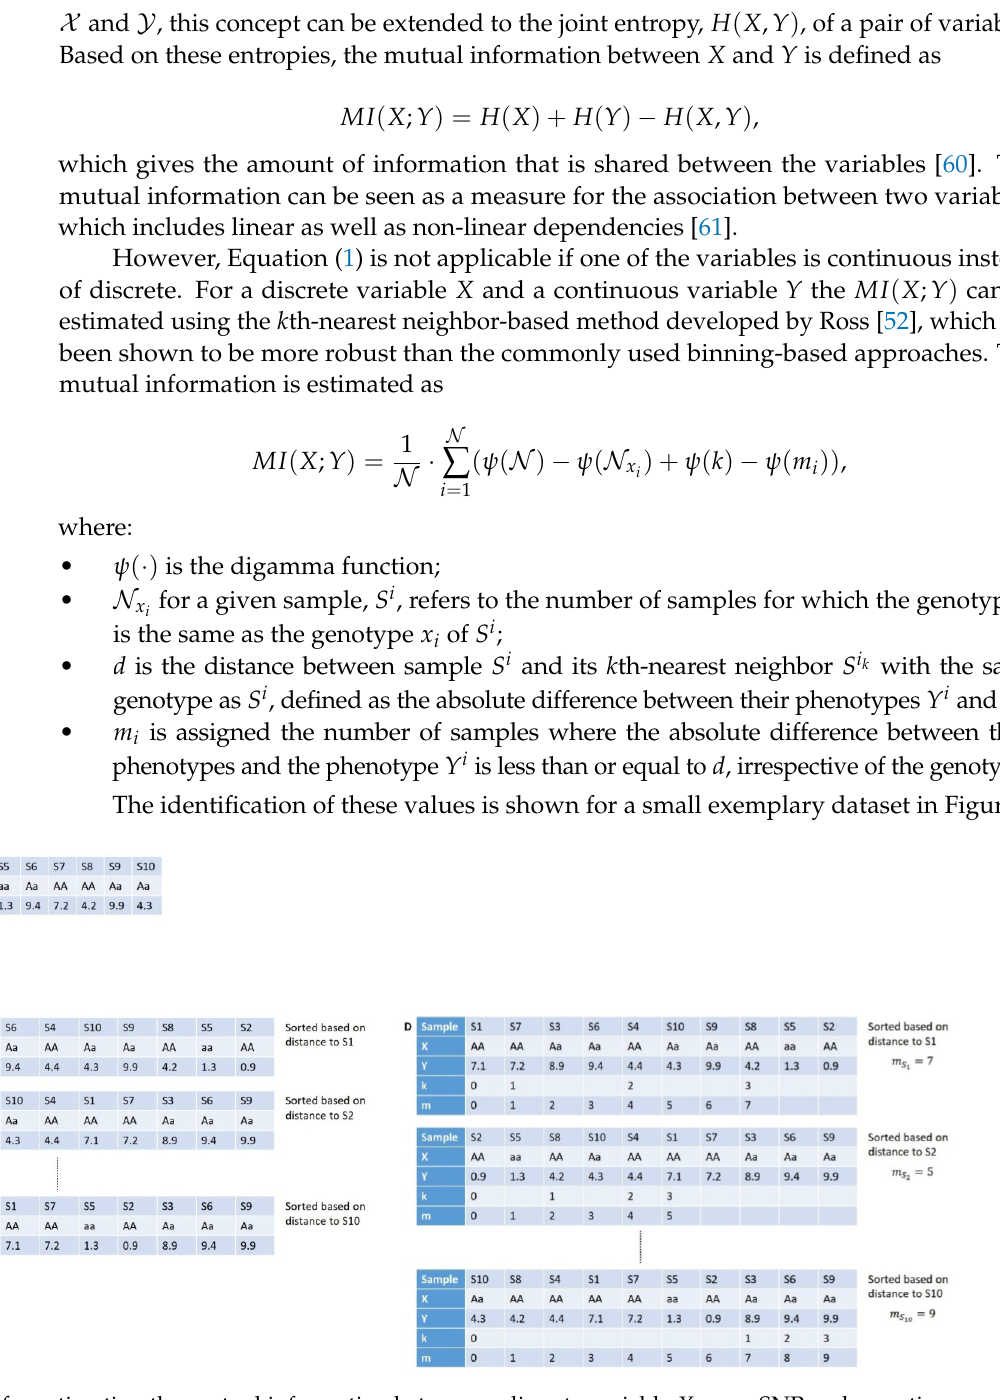
Figure 2. Procedures for estimating the mutual information between a discrete variable X as an SNP and a continuous variable Y representing a quantitative phenotype using k = 3: ( A ) Genotype and phenotype values are given for ten samples S1, S2, ... to S10. ( B ) N x is defined as the number of samples where the genotype is equal to x . ( C ) For each sample, S i , a sorted list of the samples is created based on the absolute difference between Y i and Y j for sample S j . ( D ) The k th-nearest neighbor is determined for each sorted list by going along the list and counting the samples that have the same X value as the start sample. m S can then be defined as the index of the k th-nearest neighbor in the sorted list. For sample S1 which has i the X value AA , the sample with the third-closest Y value and the same X value is sample S8, which has the index 7 in the = 7. Based on the N x and m sorted list. Therefore, m S S i values, the mutual information can be 1